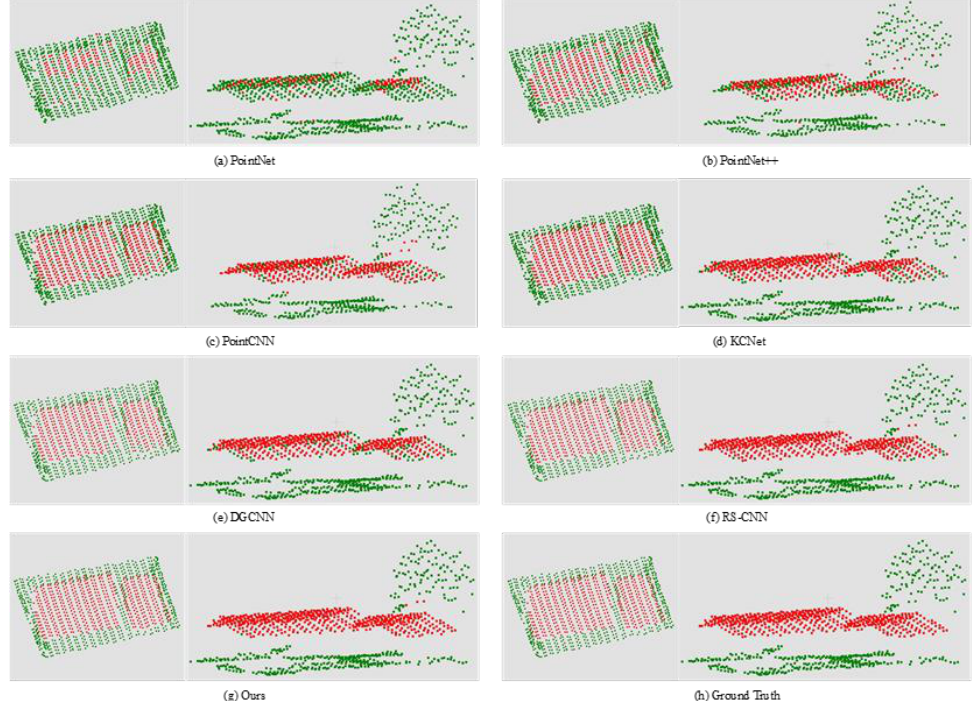
Figure 11. The details visualization of normal level comparison results. For each model, the left image is the vertical view, and the right image is the side view.